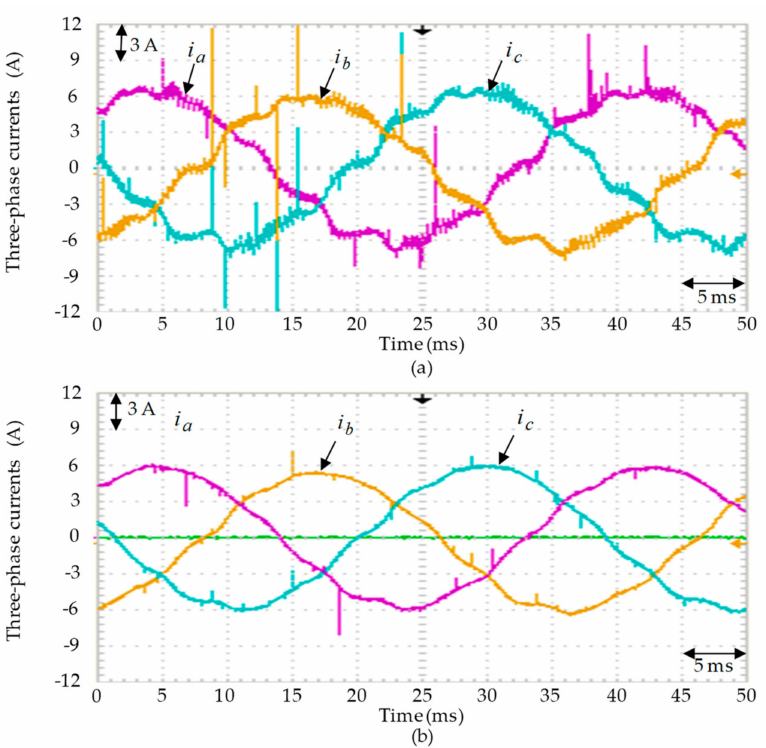
Figure 9. Responses of three-phase currents via experimental results for the ISM driving the rice milling machine system in test JA by adopting the controllers: ( a ) TA; ( b ) TB.